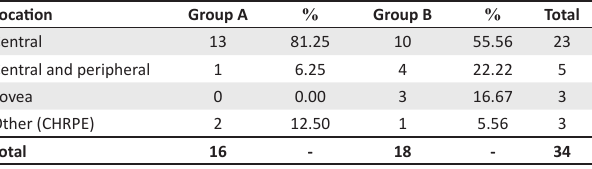
TABLE 7: Fundus auto fluorescence – retinal pigment epithelium analysis of location of abnormality (central, central and peripheral, and fovea).